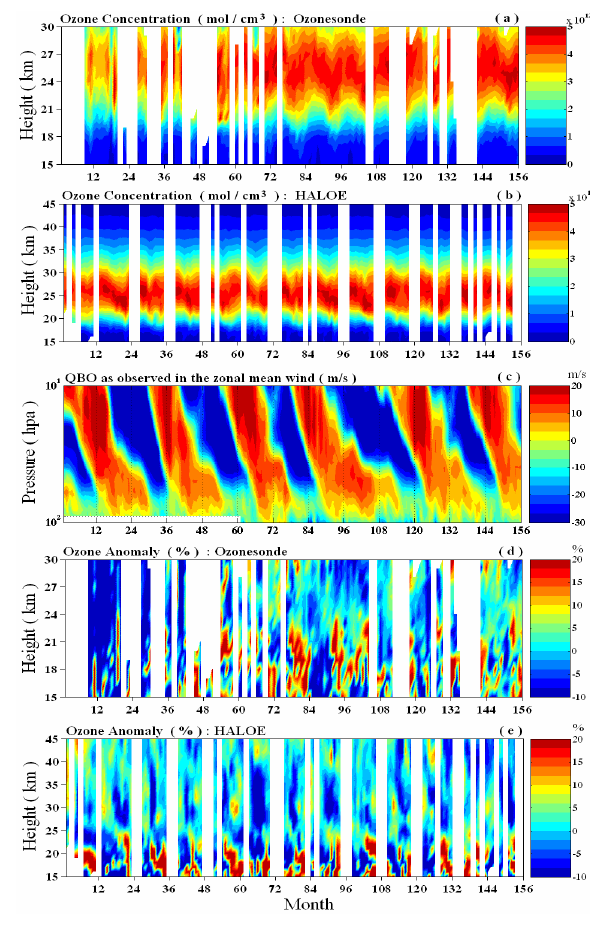
FIGURE–7: (a-b) Height-time-Monthly evolution of ozone concentrations obtained from the ozonesonde and HALOE measurements, Fig. 7. (a–b) Height-time-Monthly evolution of ozone concentra- (c) QBO phase illustrated from the zonal mean wind over equator (d-e) the ozone anomalies with respect to the overall monthly mean obtained tions obtained from the ozonesonde and HALOE measurements, from the Ozonesonde and HALOE measurements for the period from (c) QBO phase illustrated from the zonal mean wind over equator January 1992 to December 2004. (d–e) the ozone anomalies with respect to the overall monthly mean obtained from the ozonesonde and HALOE measurements for the period from January 1992 to December